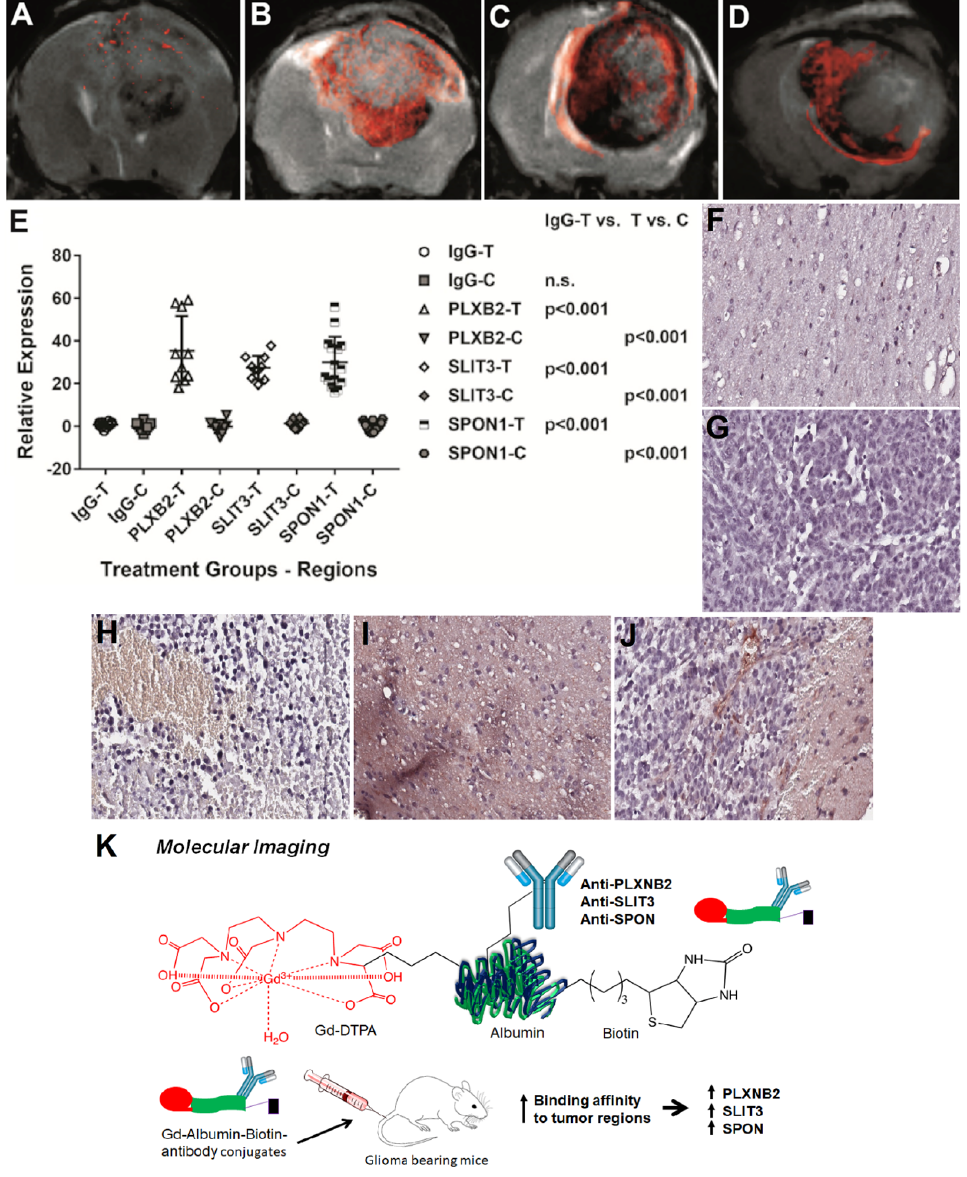
Figure 3. PLXNB2, SLIT3, and SPON1 are all highly expressed in untreated GL261 tumor ‐ bearing mice, as determined from in vivo mt ‐ MRI using specific probes for each biomarker. Images were obtained at maximum tumor volumes (approx. 21 days from GL261 cell implantations). Representative mt ‐ MRI contrast difference images (false ‐ colored in red) overlaid on top of morphological MR images (grayscale) for non ‐ specific IgG ( A ), PLXNB2 ( B ), SLIT3 ( C ), and SPON1 ( D ). Probe construct bases were a Gd ‐ DTPA ‐ albumin ‐ biotin combination, where the specific antibody (anti ‐ PLXNB2, anti ‐ SLIT3, or anti ‐ SPON1) was conjugated directly to the albumin linker. ( E ) Relative expression of non ‐ specific Gd ‐ DTPA ‐ albumin ‐ IgG ‐ biotin, Gd ‐ DTPA ‐ albumin ‐ anti ‐ PLXNB2 ‐ biotin, Gd ‐ DTPA ‐ albumin ‐ anti ‐ SLIT3 ‐ biotin, Gd ‐ DTPA ‐ albumin ‐ anti ‐ SPON1 ‐ biotin probes in tumor (T) or contralateral (C) brain regions. n = 5/group with 5 ‐ 6 ROIs per animal in each region. There was a significant increase in each biomarker’s relative expression in the tumor regions when compared to the non ‐ specific IgG tumor regions ( p < 0.001 for each). Each biomarker’s relative expressions were also significantly increased when comparing tumor vs. contralateral regions ( p < 0.001 for each). Representative tissue sections of streptavidin ‐ horse radish peroxidase (SA ‐ HRP) targeting biotin moieties of anti ‐ PLXNB2 ( H ), anti ‐ SLIT3 ( I ), or anti ‐ SPON1 ( J ) probes, indicating selective binding in tumor regions. Control SA ‐ HRP in normal brain ( F ) or tumor region ( G ) of a GL261 ‐ tumor bearing mouse treated with non ‐ specific IgG. All histology slides are 20× magnifications. ( K ) mt ‐ MRI probe synthesis and treatment schematic and summarized results.